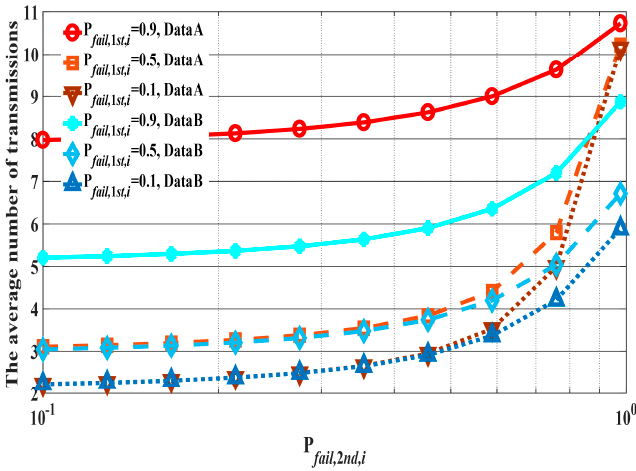
Figure 7. Examples of (cid:1872)(cid:1870) (cid:2870)(cid:3035)(cid:3042)(cid:3043) (cid:3364)(cid:3364)(cid:3364)(cid:3364)(cid:3364)(cid:3364)(cid:3364)(cid:3364) . (cid:1842) (cid:3033)(cid:3028)(cid:3036)(cid:3039),(cid:2869)(cid:3046)(cid:3047),(cid:3036) = 0.9, 0.5, and 0.1. (cid:1842) (cid:3033)(cid:3028)(cid:3036)(cid:3039),(cid:2870)(cid:3041)(cid:3031),(cid:3036) is in the range 0.1–0.9.